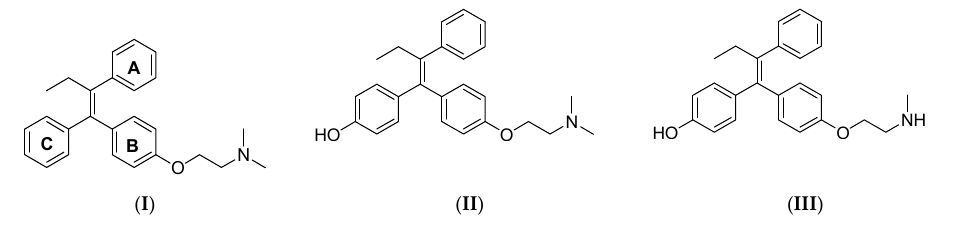
Figure 1. Structures of TAM ( I ), 4-OH-TAM ( II ), and endoxifen ( III ).